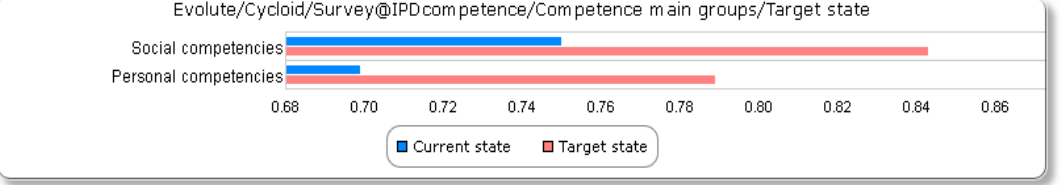
Figure 4. Project managers’ group competencies sorted according to their significance (current and target state).